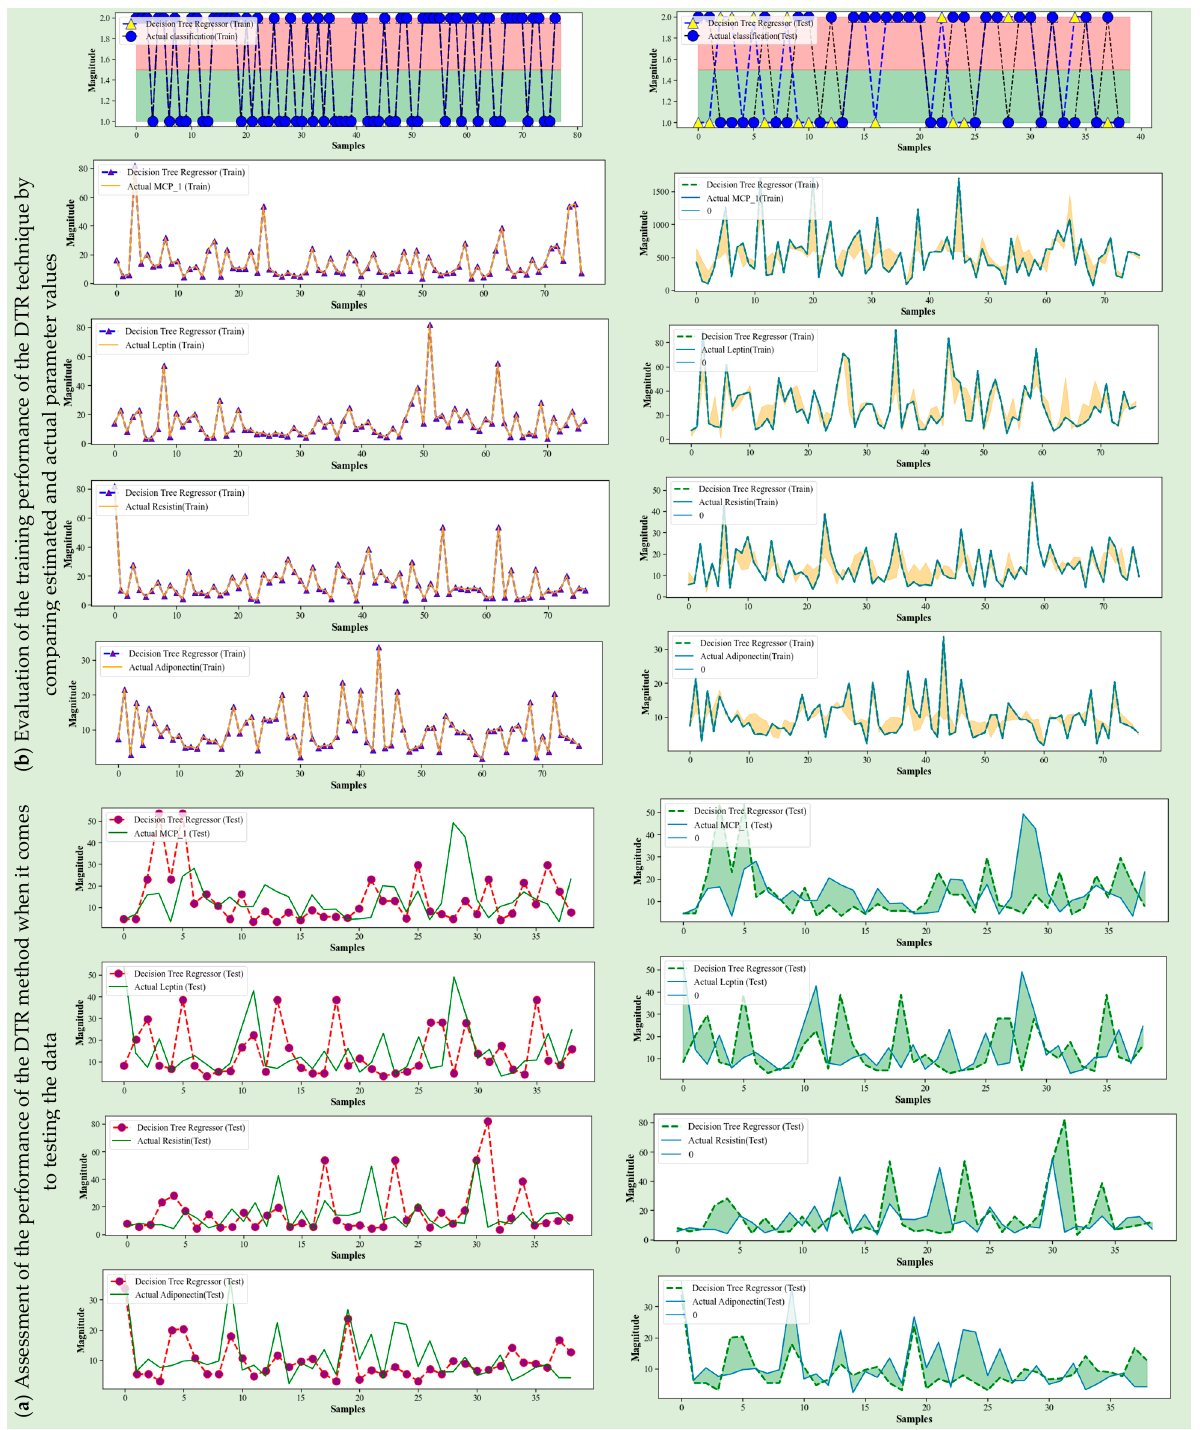
Figure 5. Digital twins of cancer are created through machine learning using ml linear regression. The performance of the DTR technique is evaluated by comparing the estimated and actual parameter values during the training phase. In the testing phase, the effectiveness of the DTR method is assessed by analyzing its performance on the data.